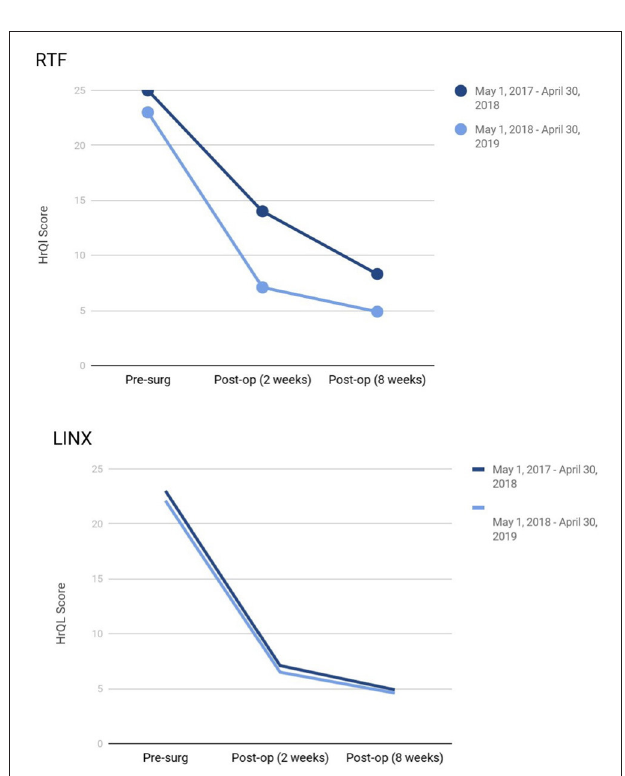
FIGURE 7 | Two-year trends in HRQL scores for patients undergoing LINX ® and